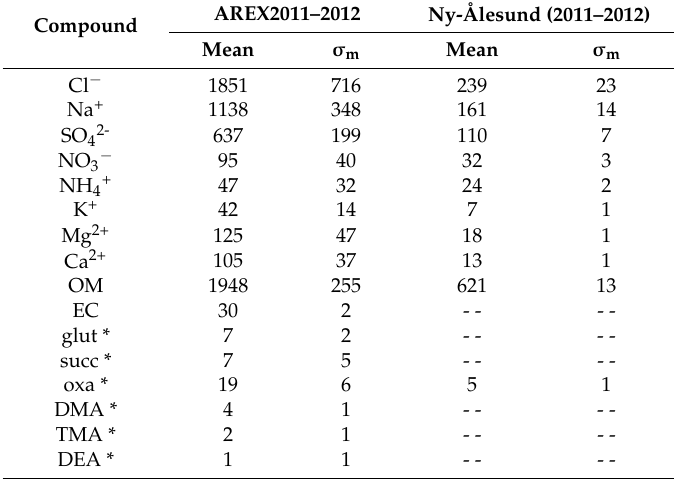
Table 1. Average values in ng m −3 (and mean standard deviation) of inorganic ions, OM, EC, carboxylic acids, and amines determined during the summers of 2011–2012, both along the AREX cruise and in Ny-Ålesund (Grivebadet station); * indicates that the concentrations reported for both carboxylic acids and amines are also part of the OM concentration while - - inticates the chemical species not determined in Ny-Ålesund.